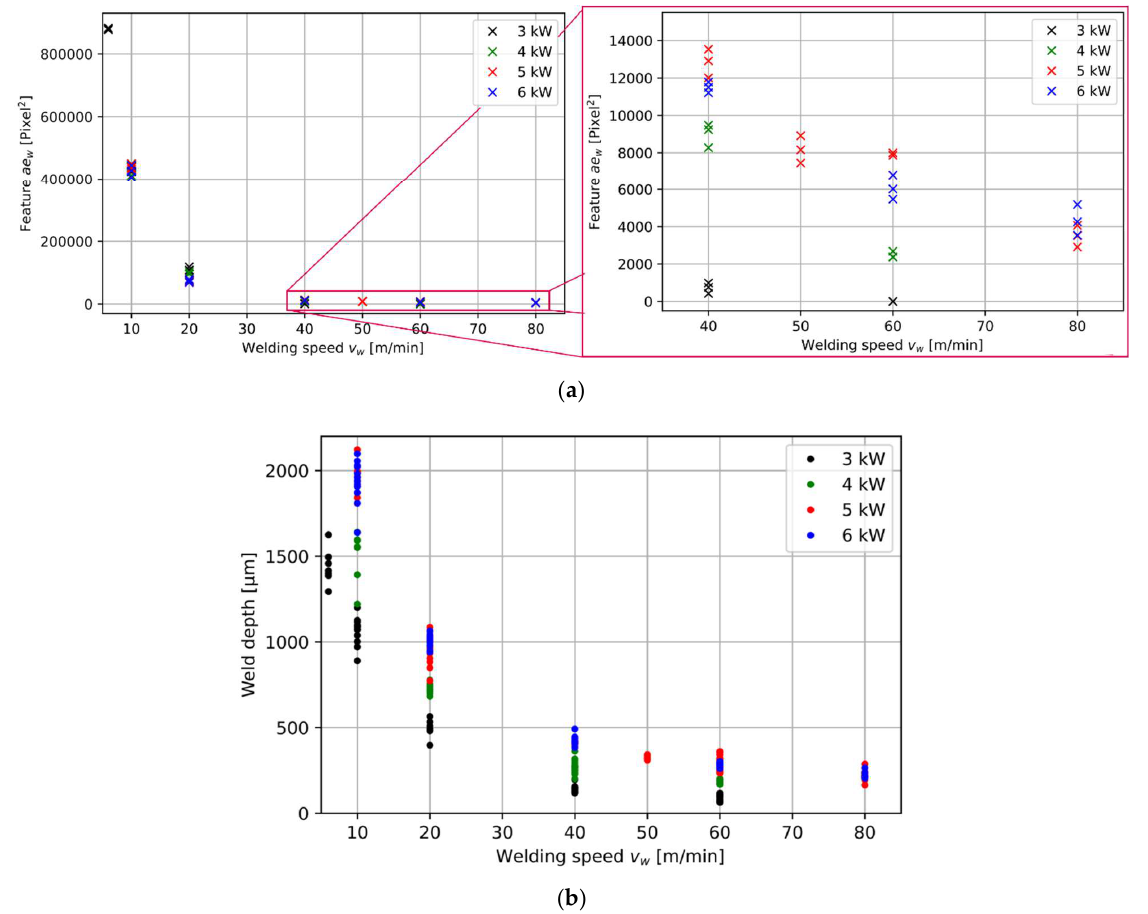
Figure 4. ( a ) Feature value over welding speed for different laser powers; ( b ) Metallurgical weld depth over welding speed for different laser powers.